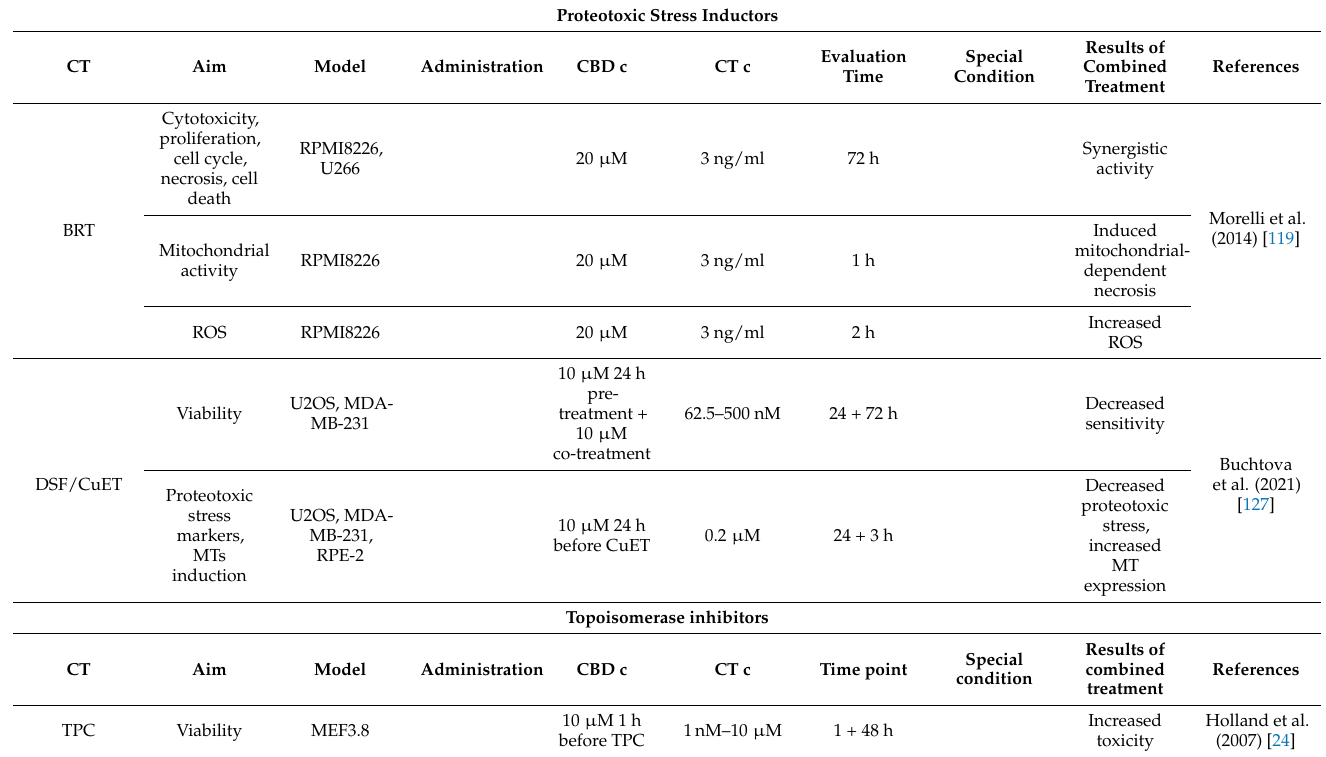
Table 5. Summary of the drug–drug interactions of CBD with proteotoxic stress inductors and topoisomerase